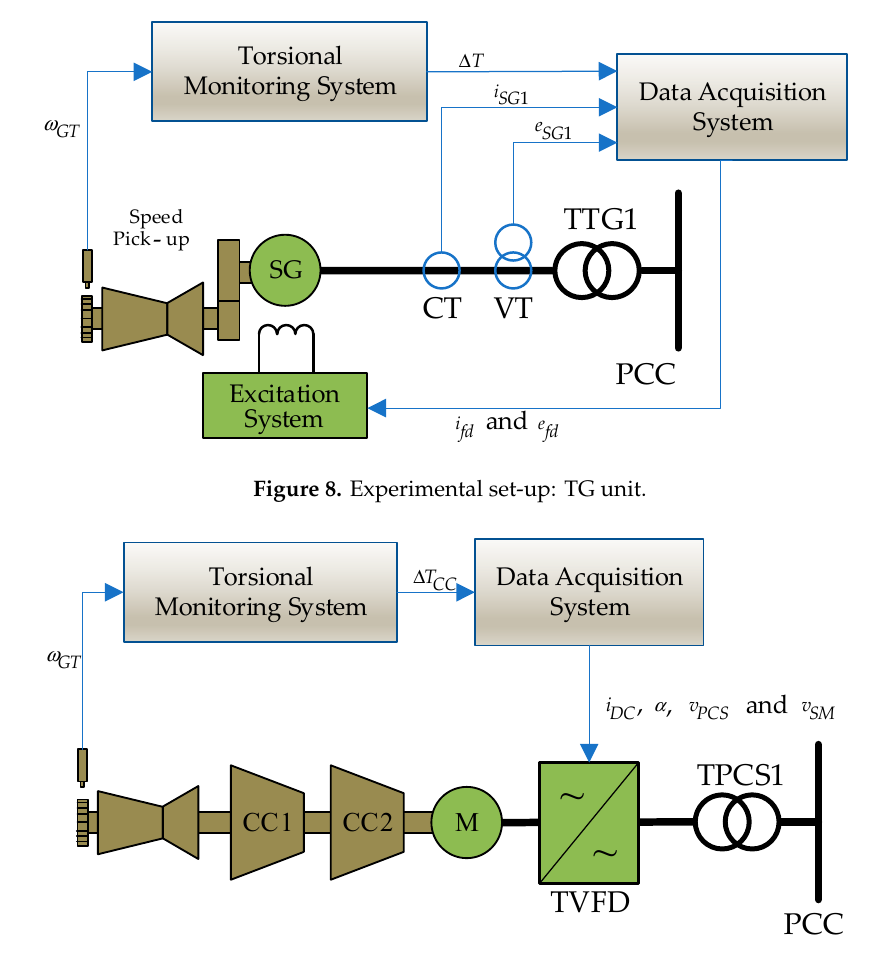
Figure 9. Experimental set-up: PCS and moto-compressor train.